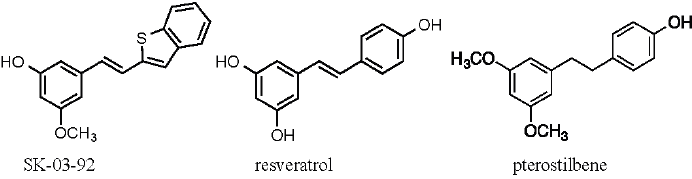
Figure 1. Structures of SK-03-92, resveratrol, and